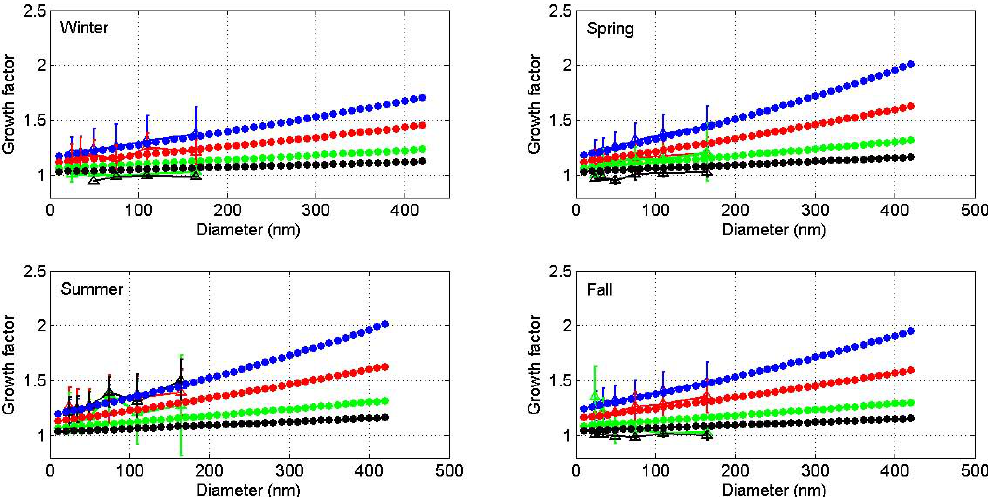
Fig. 10. Growth factor parameterization as a function of particle size and relative humidity (black=40%, green=60%, red=80%, blue=90%). Mean measurements and standard deviation are given for the comparison (triangles); the colours correspond to different relative humidities and respect the code previously defined. February 2007–February 2012, Puy de